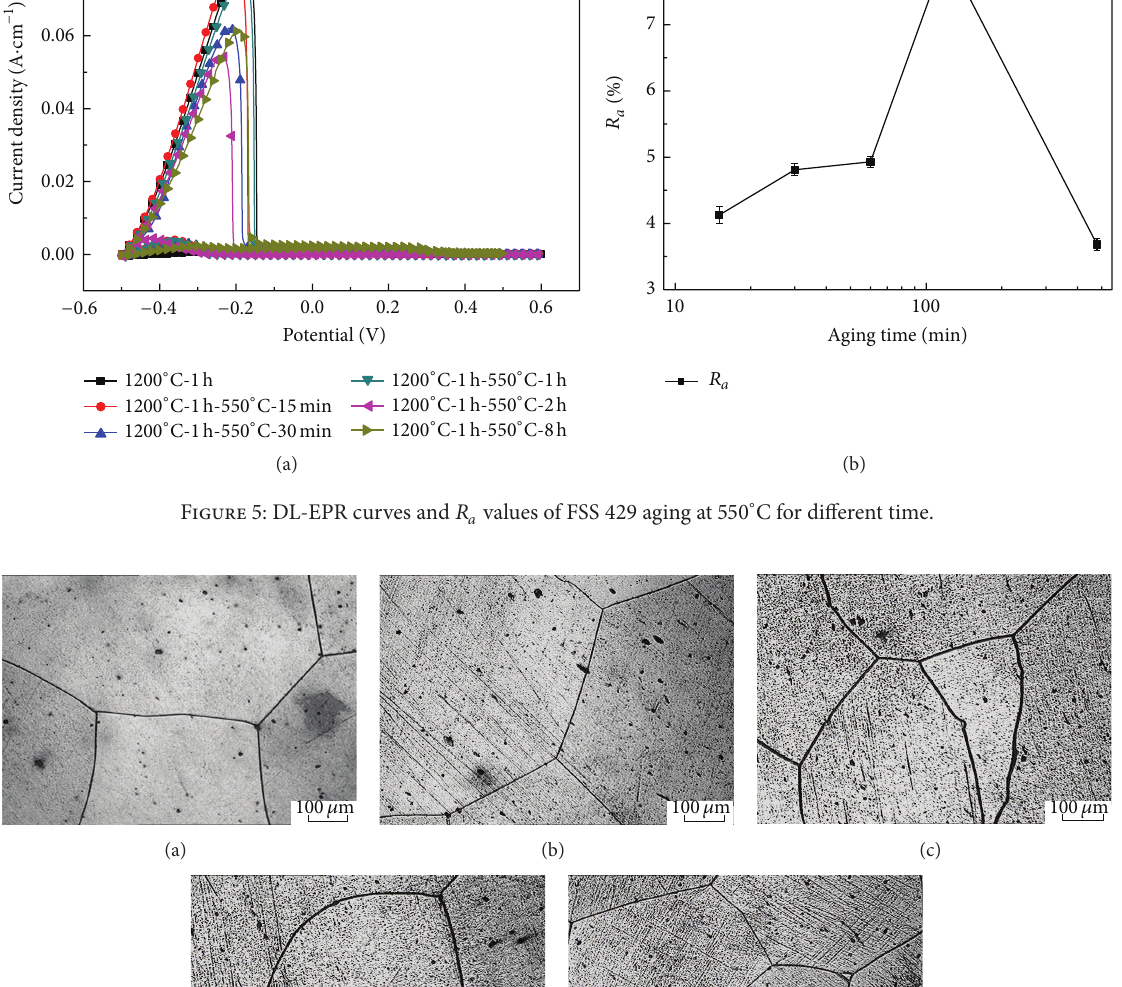
boundary of the specimen aged at 550 ∘ C for 1 h was